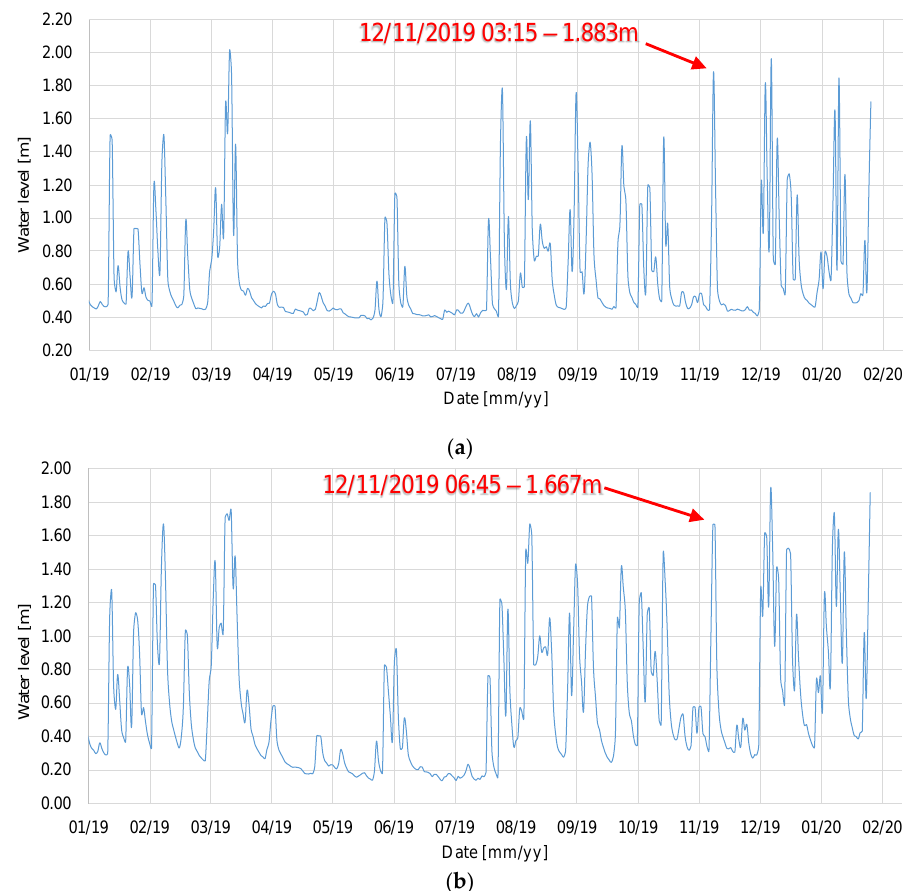
Figure 22. ( a ) Water level time-history at Dalgig station; ( b ) and Hall Bridge station from Jan. 2019.